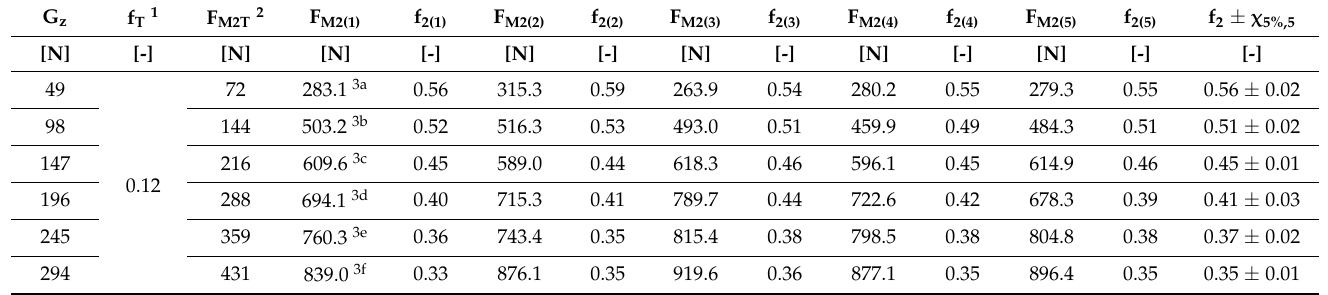
Table 2. Tensile force F M2(i) [N] , ϕ6 mm rope, semi-circular groove, clean condition.